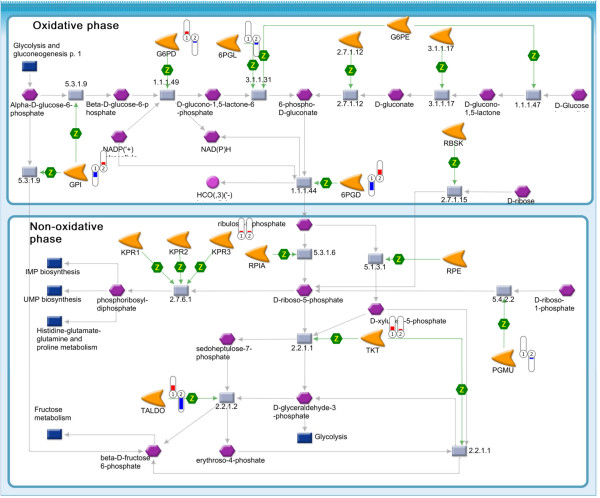
Map of pentose phosphate pathway (Genego Metacore) overlapped with quantile-normalized estimations of protein abundance. Flags indicate direction of change (red, up-increased, blue; down-decreased) and fold change (length) of protein abundance in relation to solvent control. 1, IGF-1 and 2, Resveratrol. Results were expressed as mean for three replicate experiments for each treatment group.